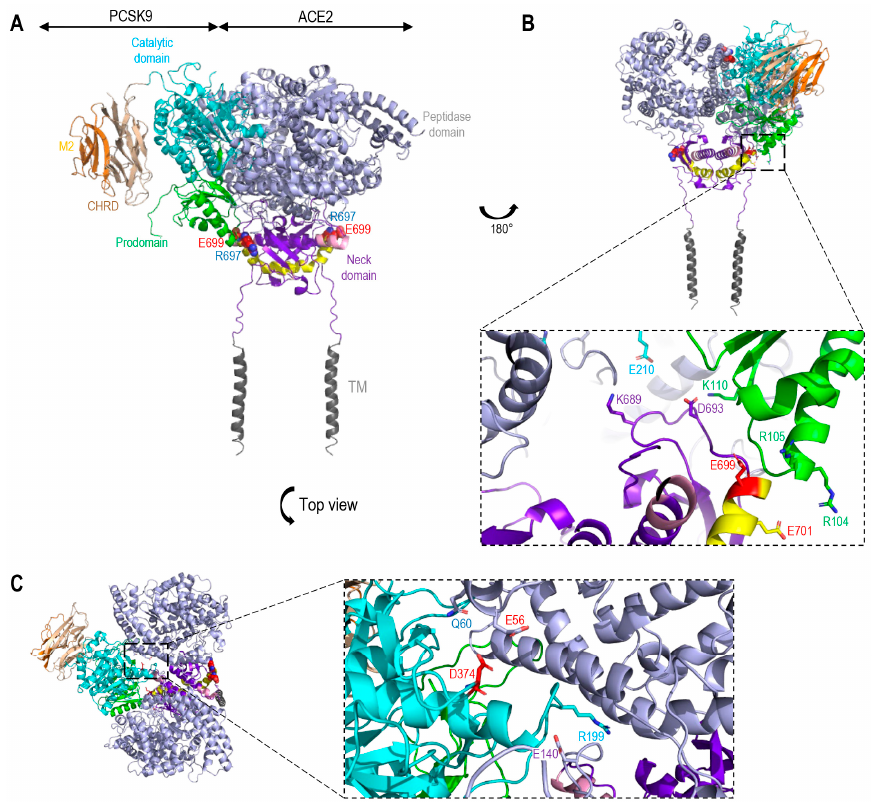
Figure 8. Molecular modeling of the interaction of OCSK9 and ACE2. ( A ) The catalytic domain (cyan) and prodomain (green) of PCSK9 (PDB code:2P4E) interacts with the extracellular domain of ACE2 (PDB code:6m18) (grey and purple). Cleavage site ADAM17 (pink). Cleavage site TMPRSS2 (yellow). ( B ) Rotation 180°, view on the binding site between the prodomain of PCSK9 (R 104 and R 105 ) and shedding domain by TMPRSS2 in ACE2 (E 699 and E 701 ) [9]. Additional binding between K 110 of the prodomain and E 210 of the catalytic domain of PCSK9 with D 693 and K 689 of the Neck domain of ACE2. ( C ) Blown up top view of the binding site between Catalytic domain of PSK9 (D 374 and R 199 ) and peptidase domain of ACE2 (Q 60 and E 140 ). Notice the predicted repulsion between D374 in PCSK9 and E56 in ACE2 (in red). TM, transmembrane domain.